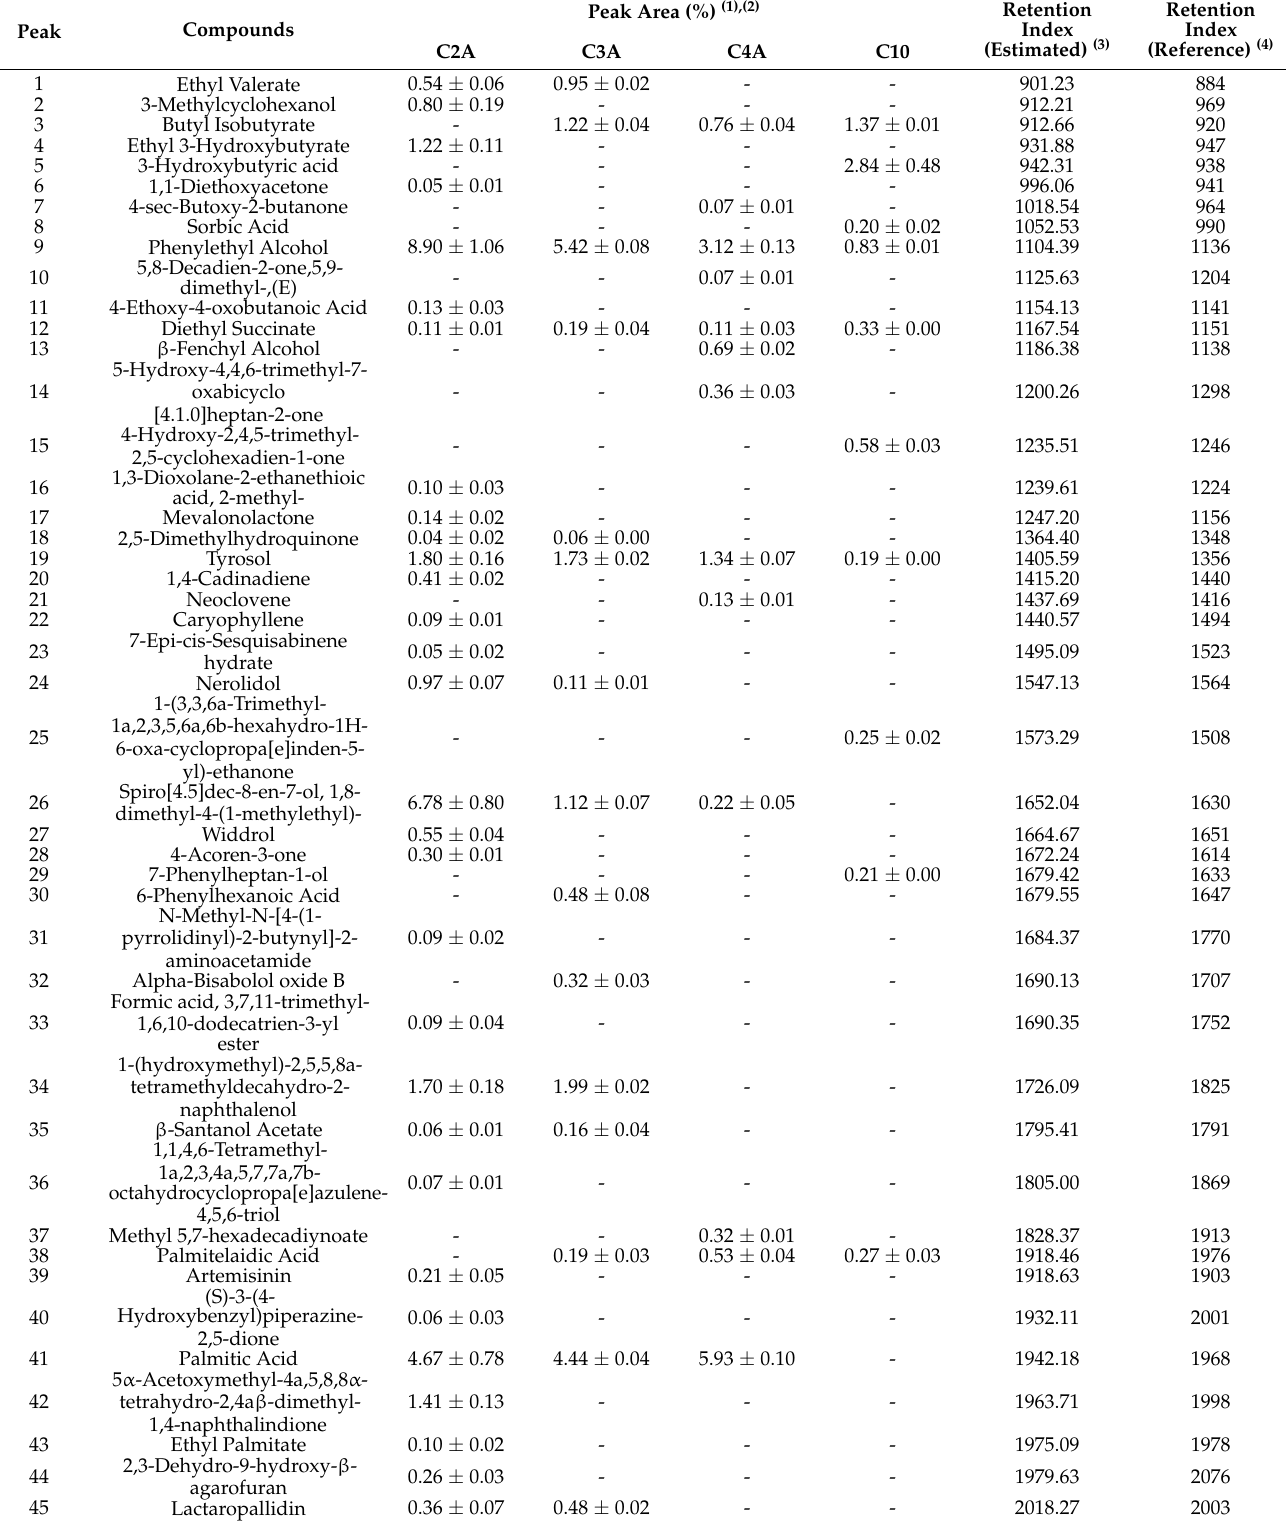
respectively. All compounds appear in order of the elution of non-polar chromatographic column, and differences between extracts of Trichoderma strains were revealed (Figure 4). Table 2. Compounds identified in Trichoderma spp. ethyl acetate